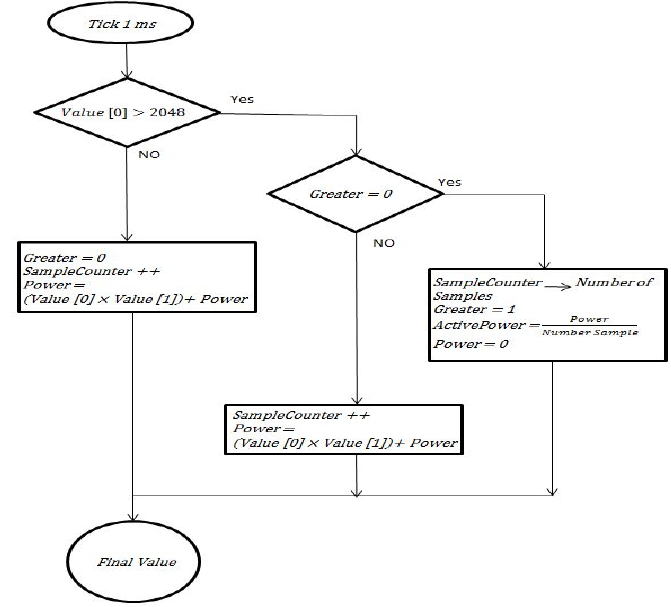
Figure 6. Autonomous AC motor speed control algorithm based on variable input surveillance.